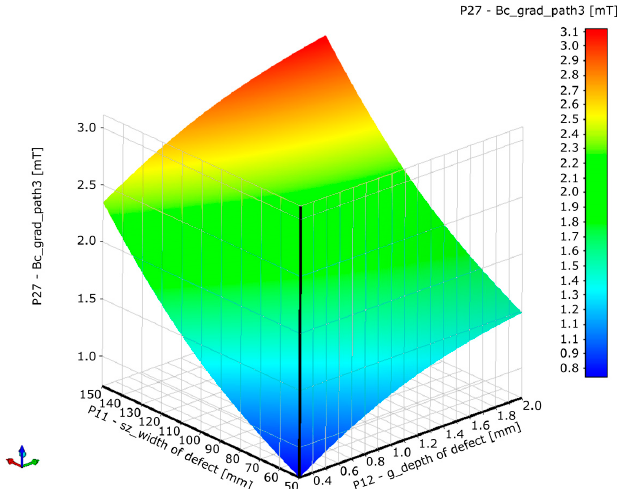
Figure 11. 3D plot showing the impact of width “sz” and depth “g” of defect onto a gradient of magnetic induction on the detection path.